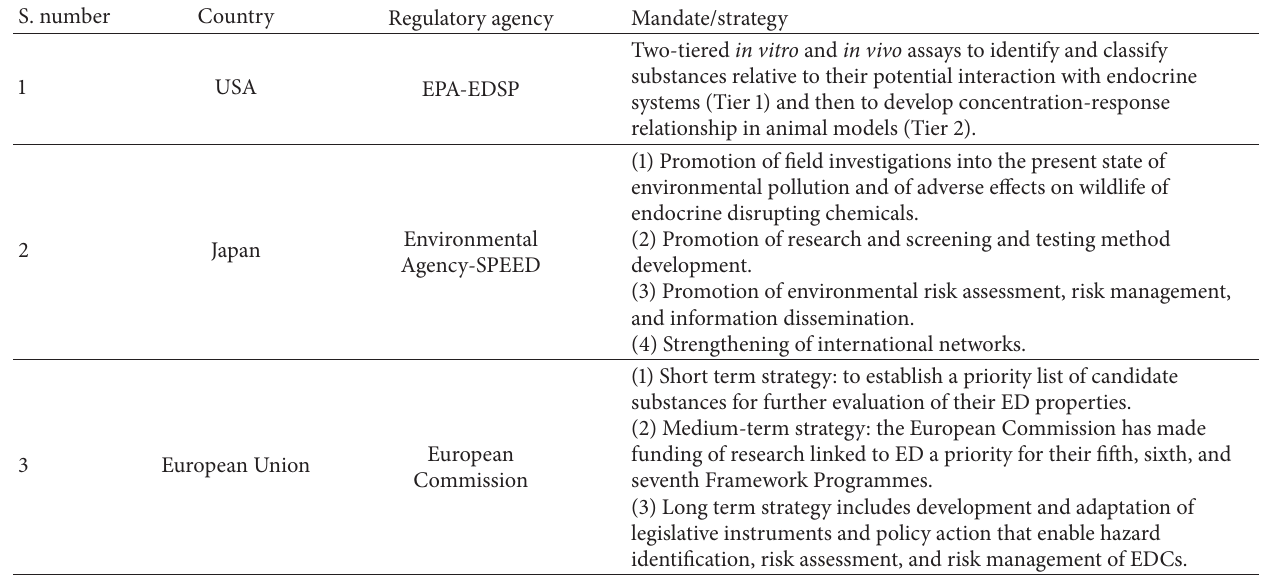
Table 1: List of countries and regulatory agencies that have devised rules for monitoring EDCs. S.